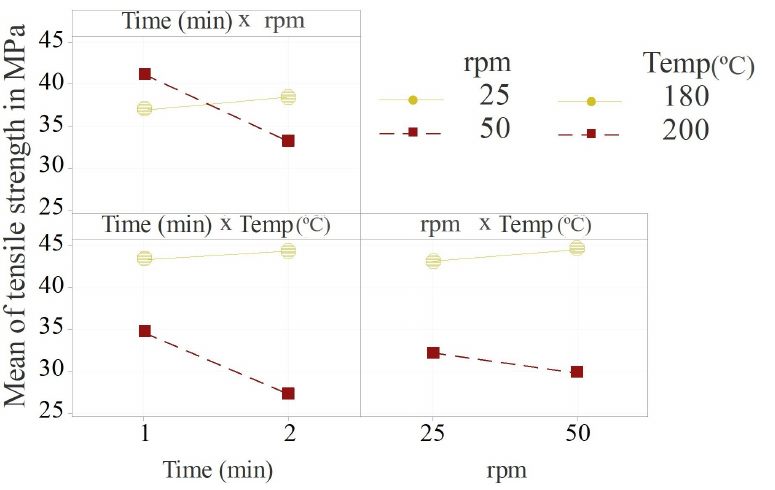
Figure 5. Interaction plots for the tensile